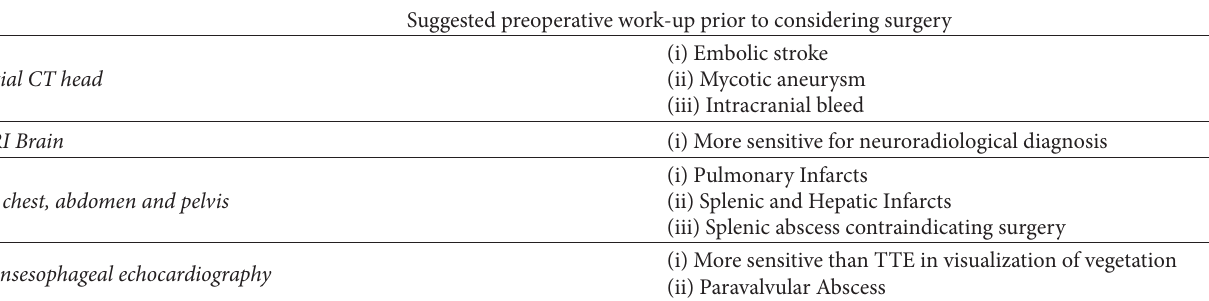
Table 4: Suggested preop workup for surgical